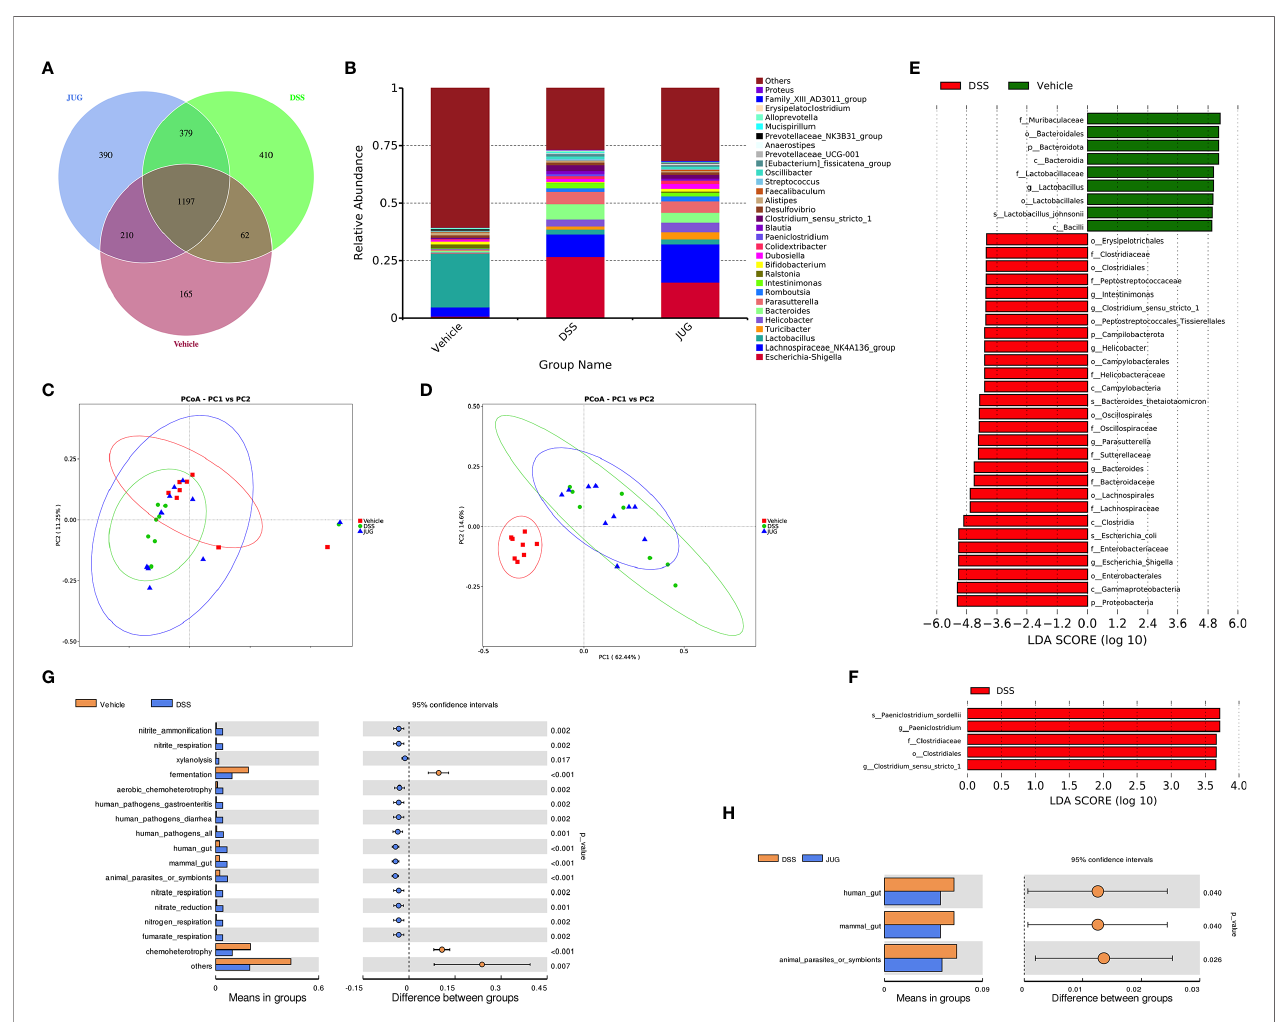
FIGURE 7 | 16S rRNA sequencing for DSS-induced gut microbial detection. 16S rRNA sequencing was employed to measure the impact of JUG on the gut microbiota. (A) The Venn graph of the three groups; (B) the relative abundance of the microbial population at the genus level, the unweighted unifrac PCoA diagram. (C) The weighted unifrac PCoA diagram of each group. (E, F) The LDA score of the LEfSe analysis between the DSS and Vehicle or JUG group, and the different gut microbiota functions between the DSS and vehicle LDA score > 4 (G) or JUG group LDA score > 3.6 (H) .